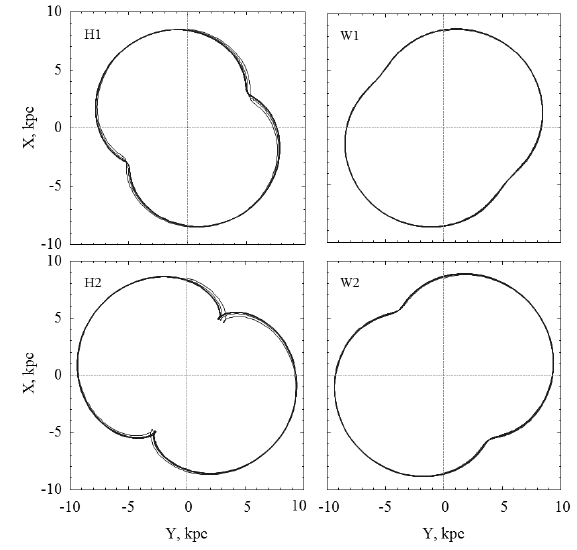
Fig. 3. Resonant orbits in the bar rotating frame constructed from averaged data for stars of the streams H1, H2 and W1, W2 in a non-axisymmetric Galactic potential (with the